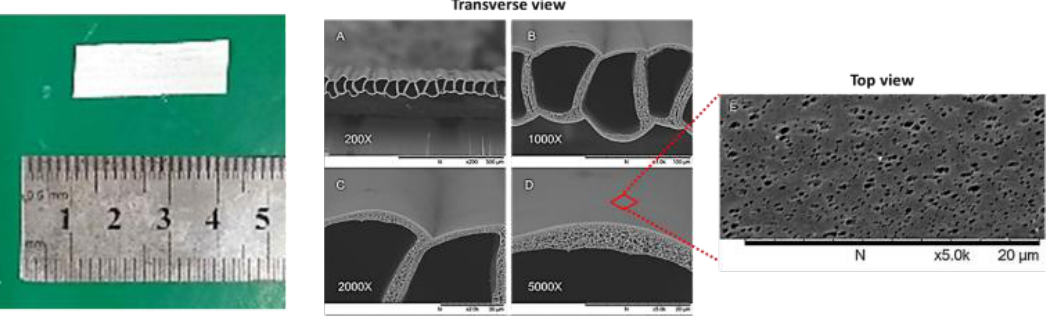
Figure 1. Macroscopic view of the electrospun polysulfone (PSF) Microtube Array Membranes (MTAMs) utilized in this study (left). SEM images of PSF MTAMs. The unique microstructures of the PSF MTAMs, which consisted of one-to-one connected, ultrathin, submicron scale hollow fibers, can clearly be observed from the transverse view ( A – D ). The individual lumen dimensions registered a value of 60.458 ± 0.488 μm × 39.549 ± 0.616 μm (Height × width; B), while the lumen wall thickness registered a value of 3.0 ± 1.0 μm (D). Top view of the PSF MTAMs revealed homogenously